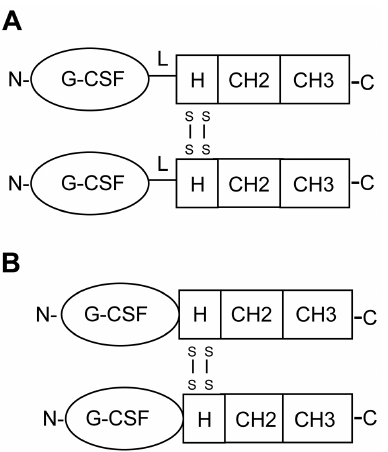
Figure 1. Schematic diagram of (A) G-CSF/IgG-FcL (linkered) and (B) G-CSF/IgG-FcD (direct) fusion proteins. In the linkered constructs, the carboxy-terminus of G-CSF is joined via a seven amino acid linker (L) to the amino terminus of IgG1-Fc and IgG4-Fc domains. In the D (direct) constructs, the carboxy-terminus of G-CSF is joined directly to the amino terminus of IgG1-Fc and IgG4-Fc domains. The hinge (H), CH2 and CH3 regions of the IgG-Fc fragments are indicated. The fusion proteins are dimeric due to disulfide bonds (S-S) that form between cysteine residues located in the IgG Hinge region.